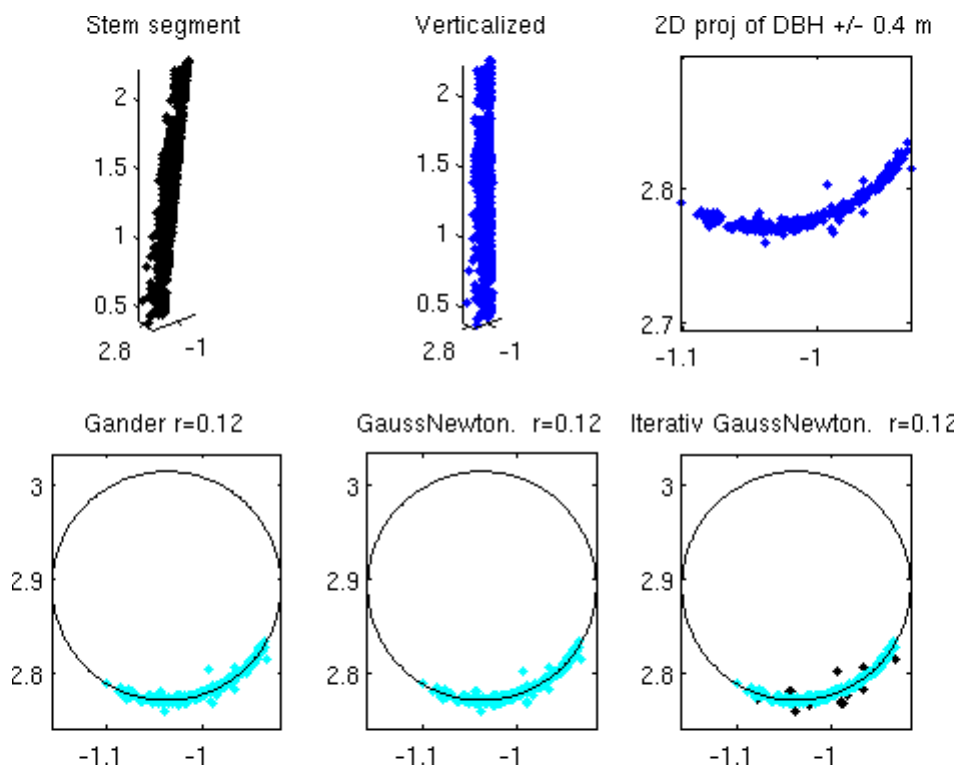
Figure 9. Upper row: An example of a stem segment before ( left ) and after ( center ) verticalization. Verticalized points at a height interval of 1.3 m ( breast height ) ˘ 0.4 m were cut out and projected to 2D ( right ). Lower row: A circle was initially fitted to all points by the method of Gander ( left ) followed by iterative Gauss–Newton ( center ). If necessary, outliers were removed, and the Gauss–Newton procedure was repeated. The rightmost subfigure shows the result after final outlier removal and with outliers as black points. In this example, the differences between the circle estimates are too small to be